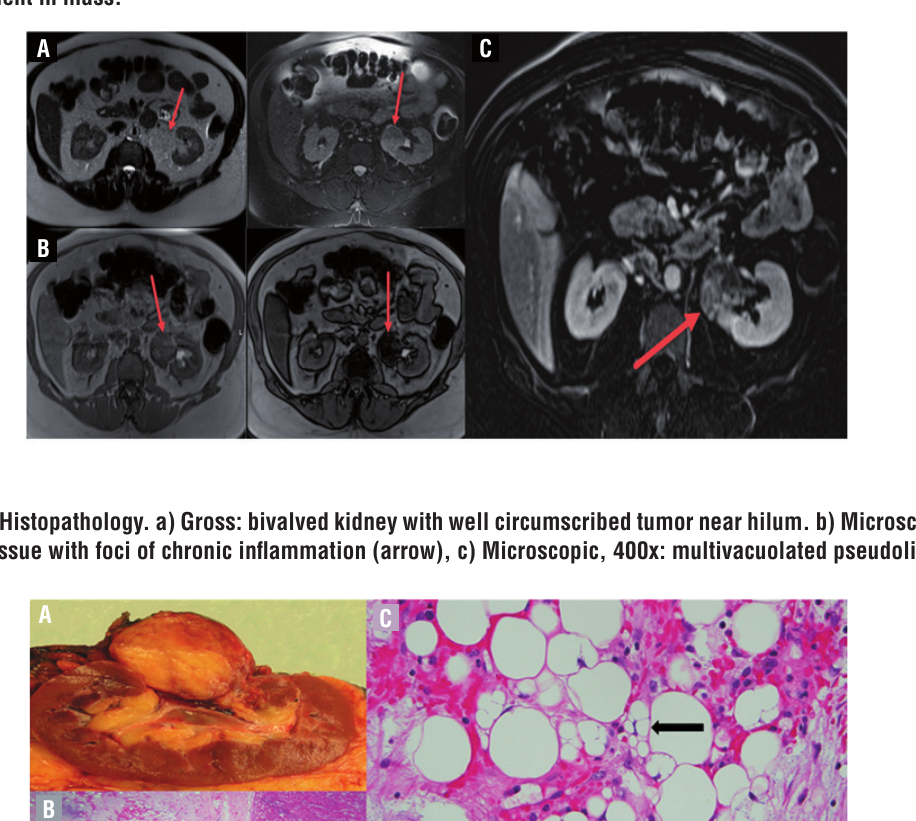
Figure 2 - MRI Images. a) Axial MRI, hAsTE (T2-weighted) (left) and hAsTE with fat-saturation (right) demonstrates the mass. b) Axial MRI, in phase (left) and opposed phase (right), c) Axial MRI, post-contrast subtracted image shows areas of enhancement in